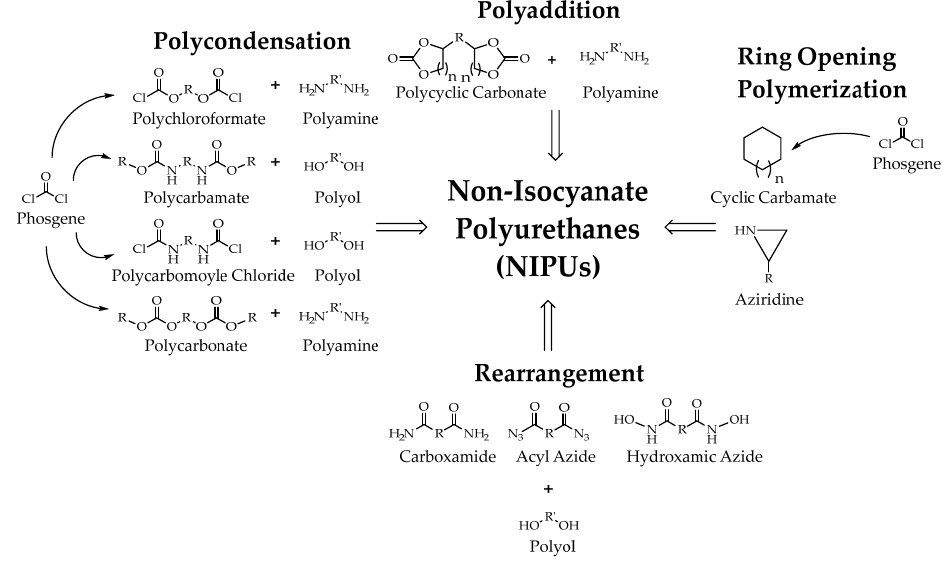
Figure 1. Main synthesis routes for NIPU synthesis.